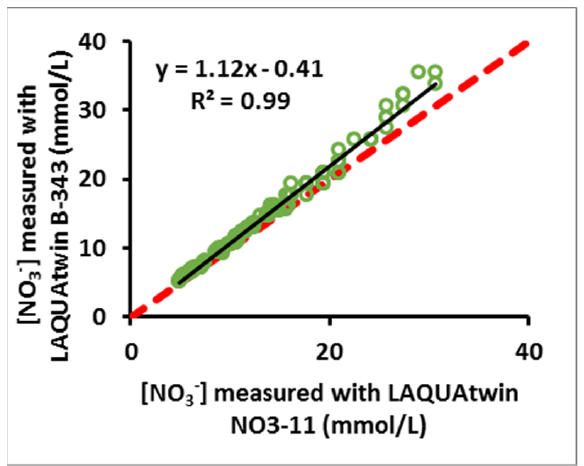
Figure 3. Relationship between values of [NO 3 − ] measured with two different ISE meters (LAQUAtwin models NO3-11 and B343) in aqueous NO 3 − solutions of known [NO 3 − ] of 6, 12 and 18 mmol NO 3 − L − 1 , when measured at sample temperature of 5, 10, 15, 20 and 25 °C. The aqueous NO 3 − solutions were prepared using three different salts, KNO 3 , Ca(NO 3 ) 2 , and NaNO 3 . [NO 3 − ] was measured with both ISE meters for at each combination of known [NO 3 − ], sample temperature, and NO 3 − source. There were three replicate measurements made for each of these combinations. The green circles are the data points. The black line is the fitted equation. The red broken line is the 1:1 line.